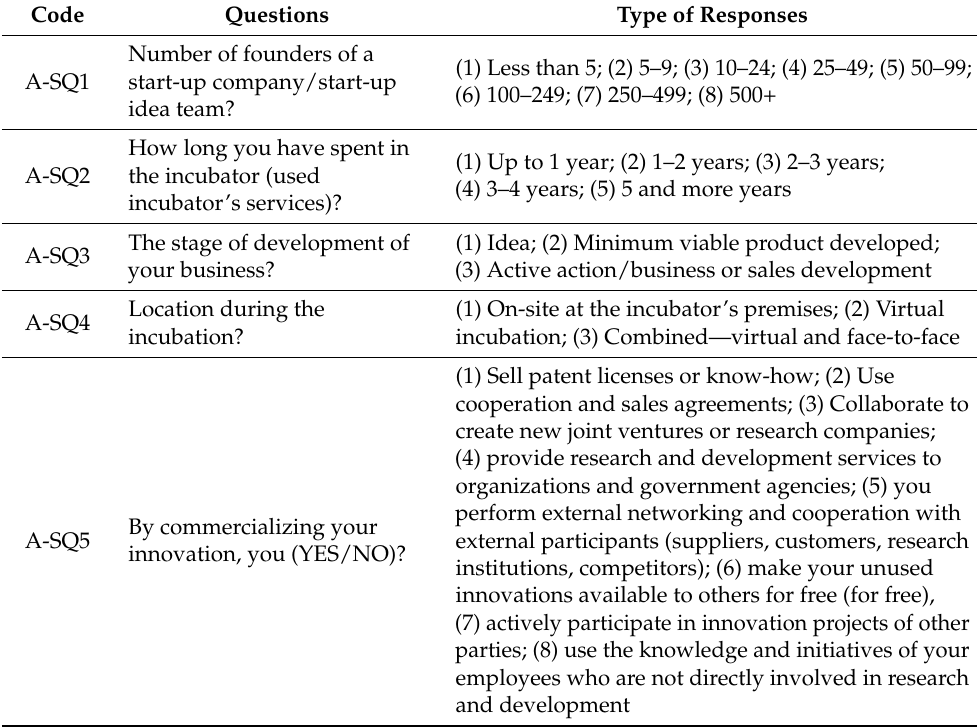
Table A2. The respondents’ profile and the start-up performance (survey).